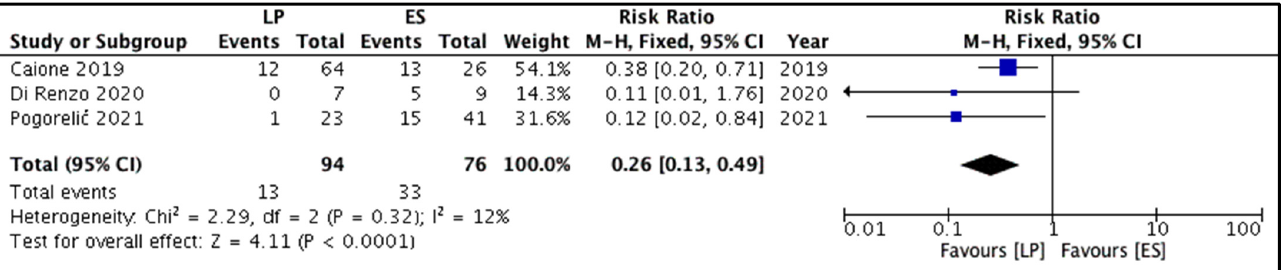
Figure 4. Forest plot comparison between the two patient groups in terms of the requirement for secondary surgical procedures. Legends: LP, laser puncture patient group. ES, electrosurgical incision patient group. M-H, Mantel-Haenszel method. CI, confidence interval.